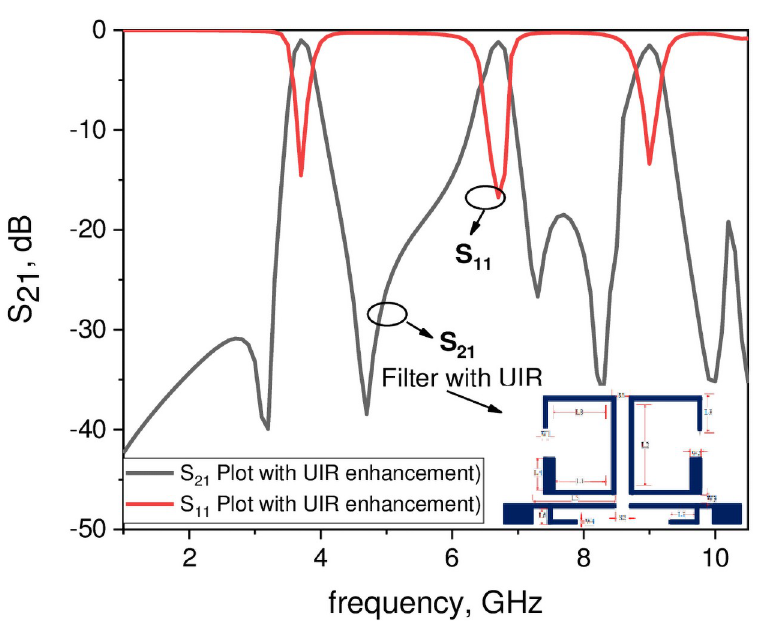
Fig 8. Frequency plots of the filter with uniform impedance resonator (UIR).